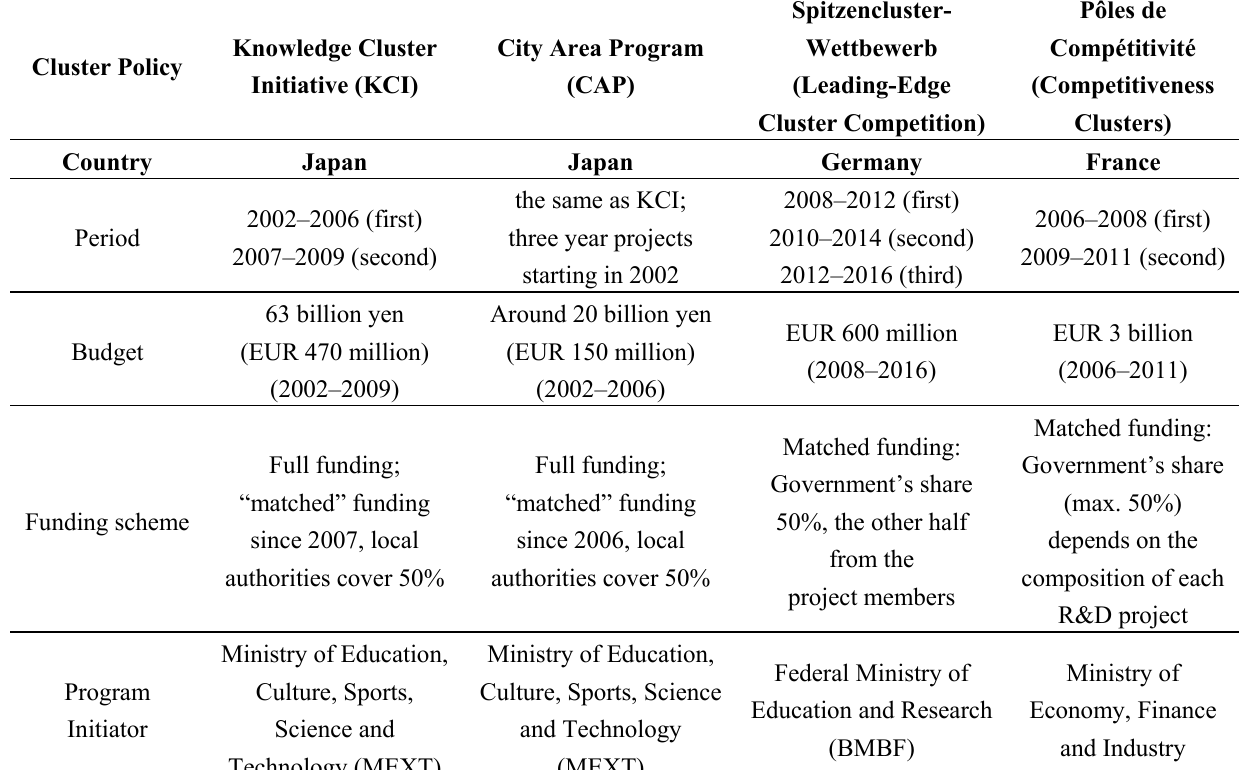
Table 2. Comparison of National Cluster